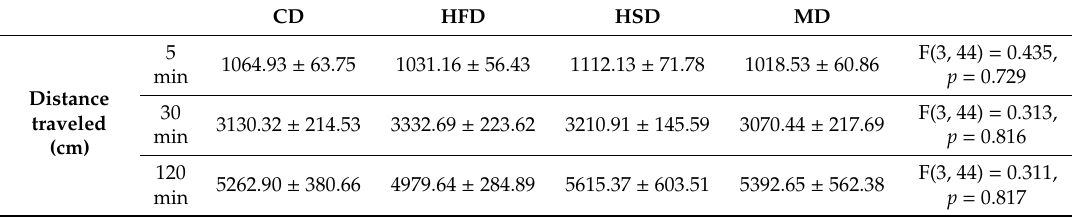
Table 2. Locomotor activity of female o ff spring at postnatal day